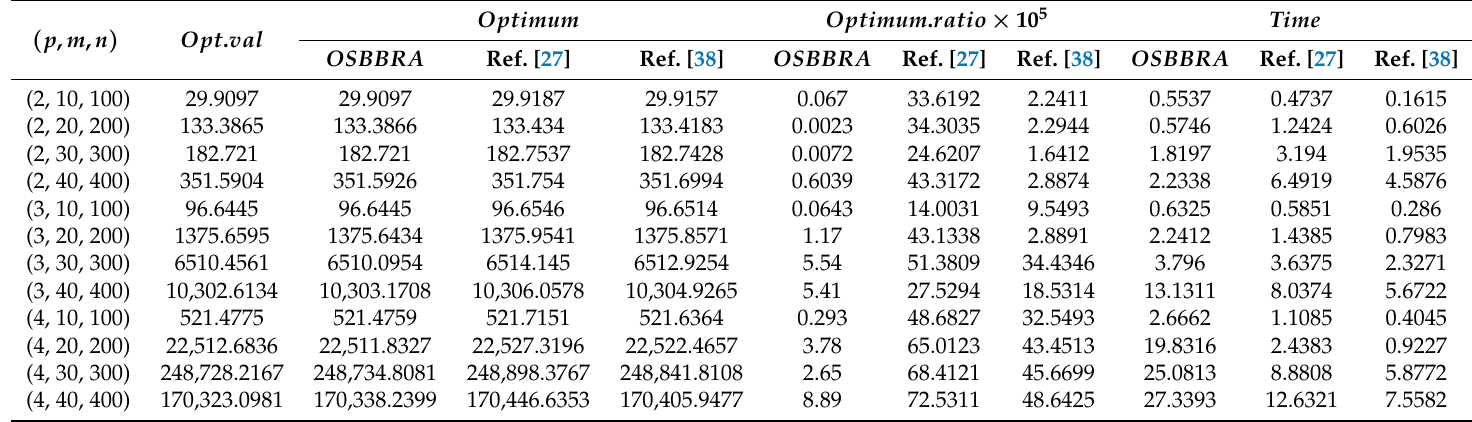
Table 2. The average result of 10 low-dimensional random problems